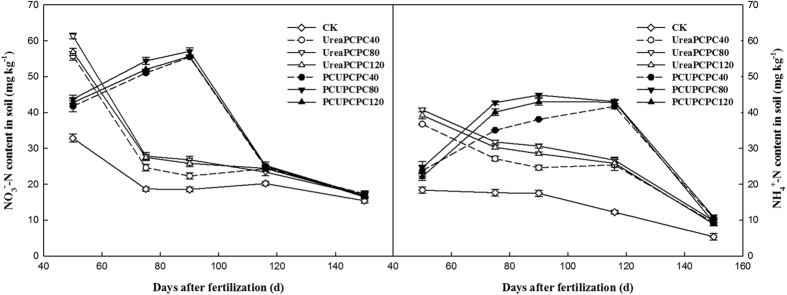
Changes of NO3−-N and NH4+-N contents.